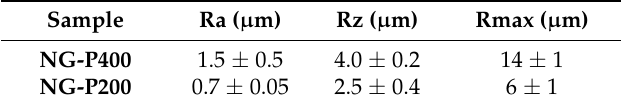
Table 2. Roughness values 1 of patterned GelMA electrospun mats.